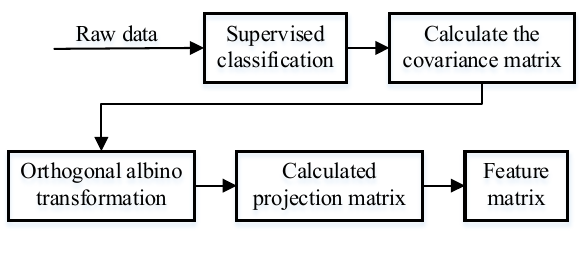
Figure 2. Diagram of CSP feature extraction